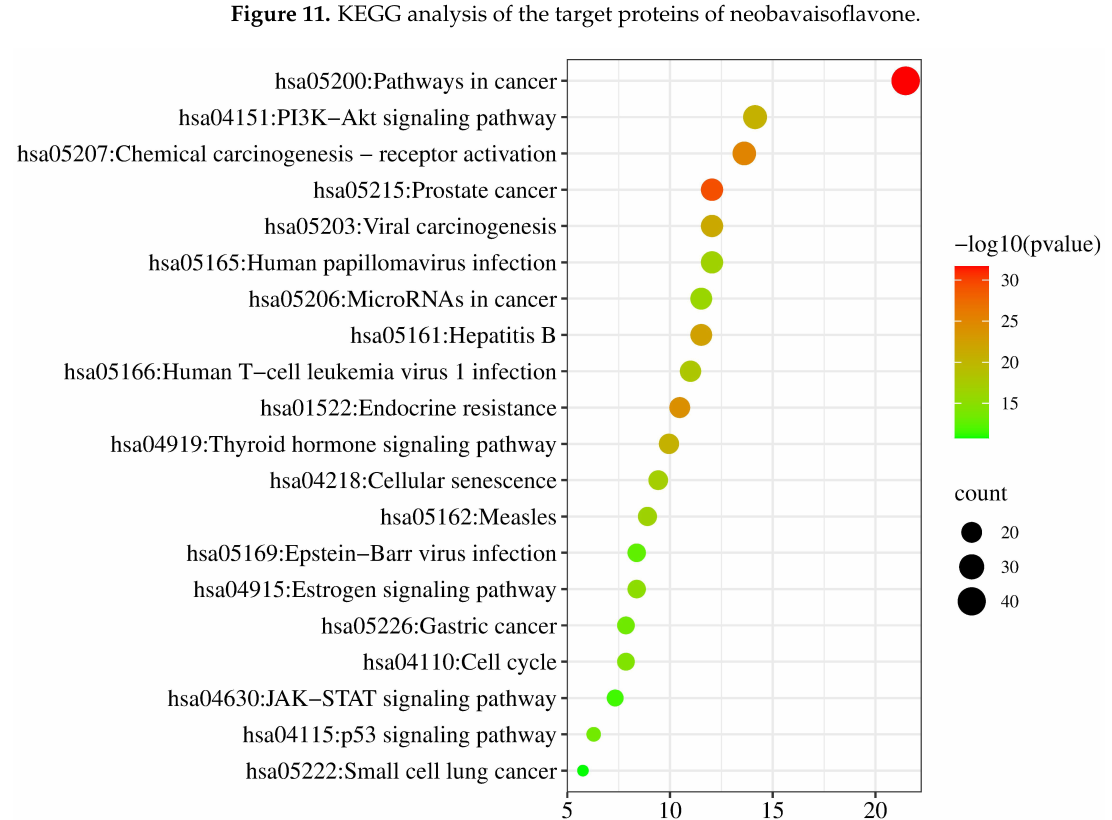
Figure 12. KEGG analysis of the target proteins of neobavaisoflavone and its